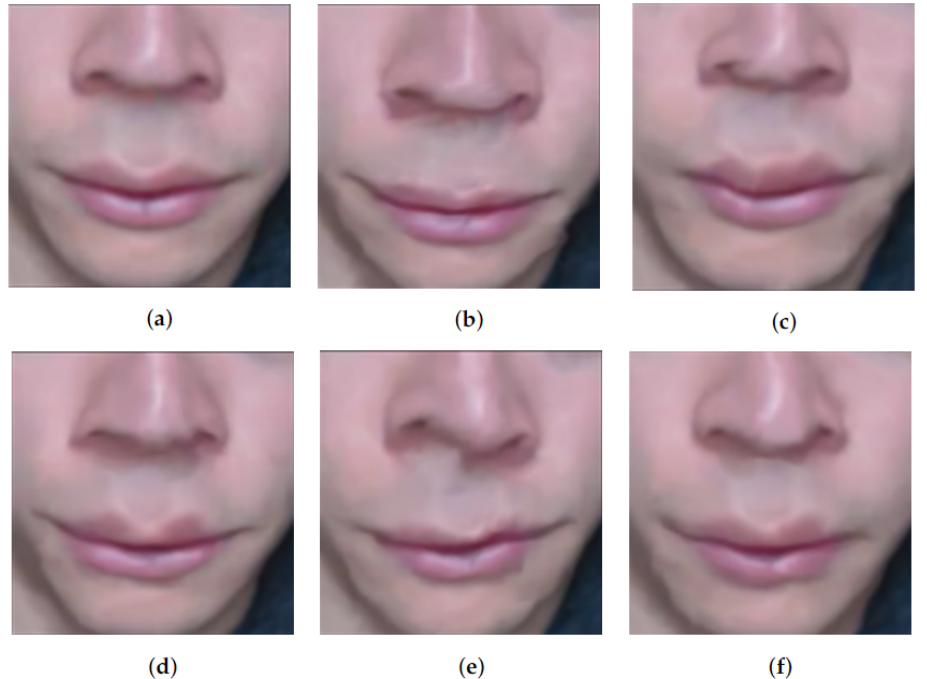
Figure 5. Bottom face frames after applying the video magnification technique. ( a – f ) sequence of frames with video magnification technique applied